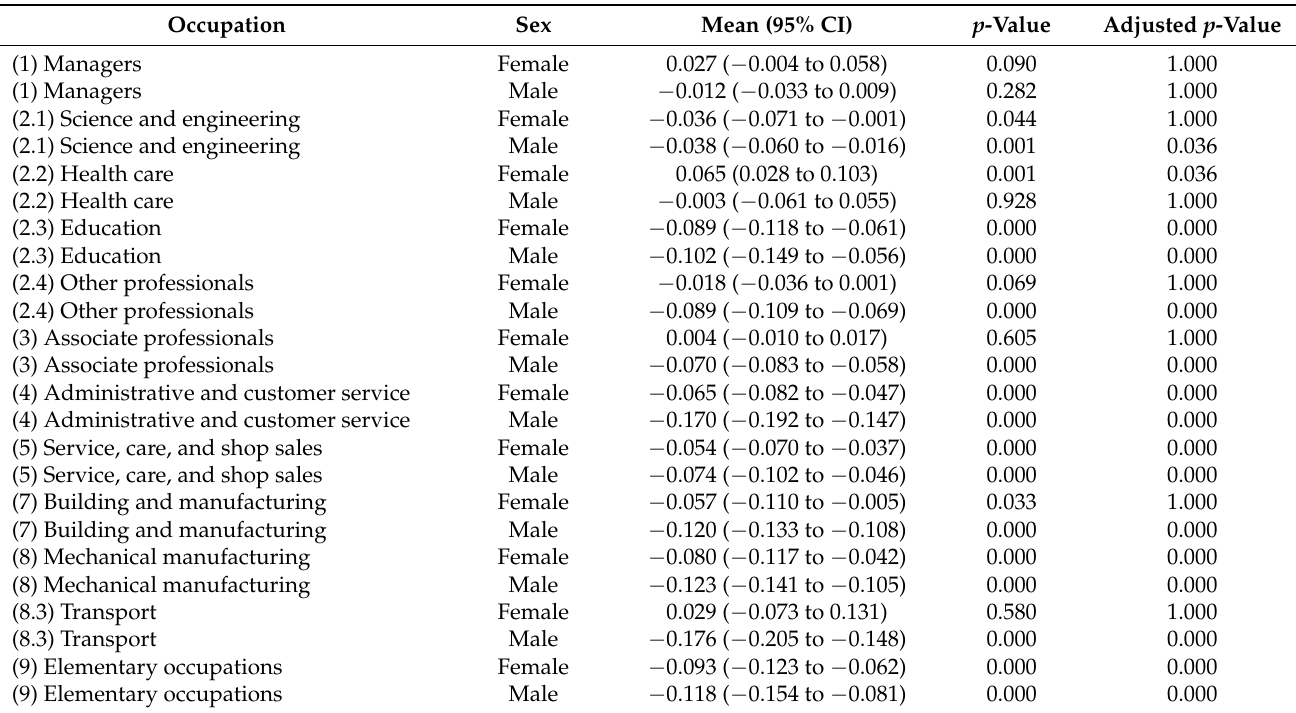
Table A2. Interaction effect linear regression model according to sex.